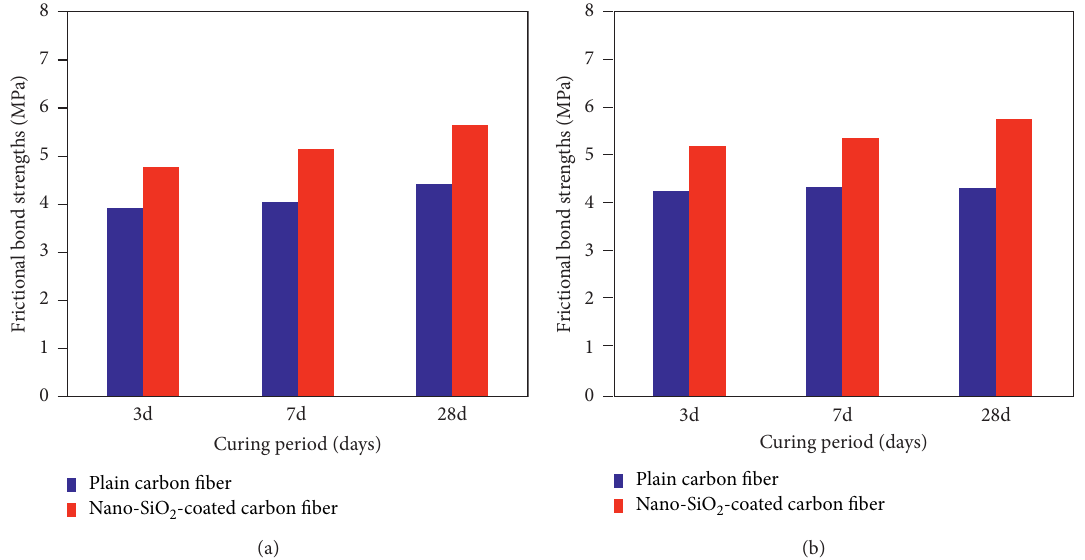
Figure 10: Variation of frictional bond strength at 3, 7, and 28 days of age. (a) Carbon fiber without SF. (b) Carbon fiber with 10 wt.%